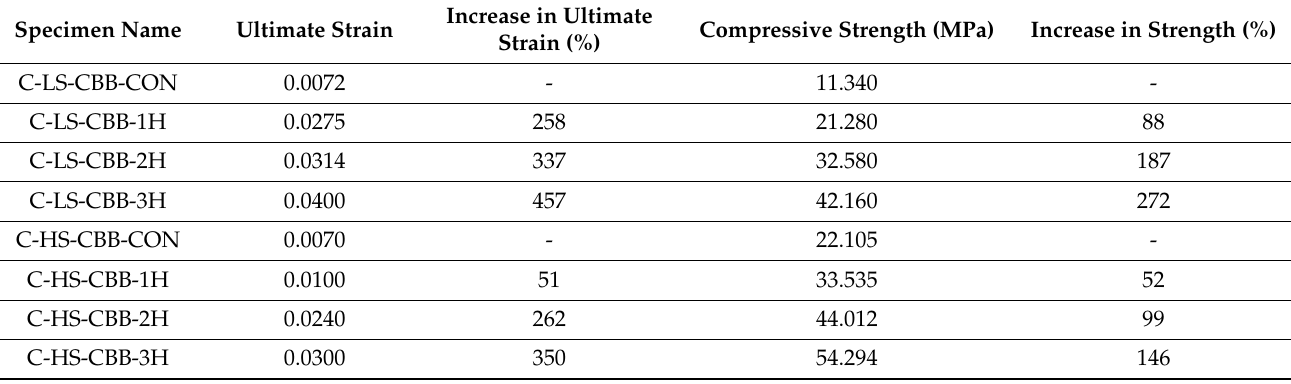
Table 4. Result summary of Type-1 concrete specimens.